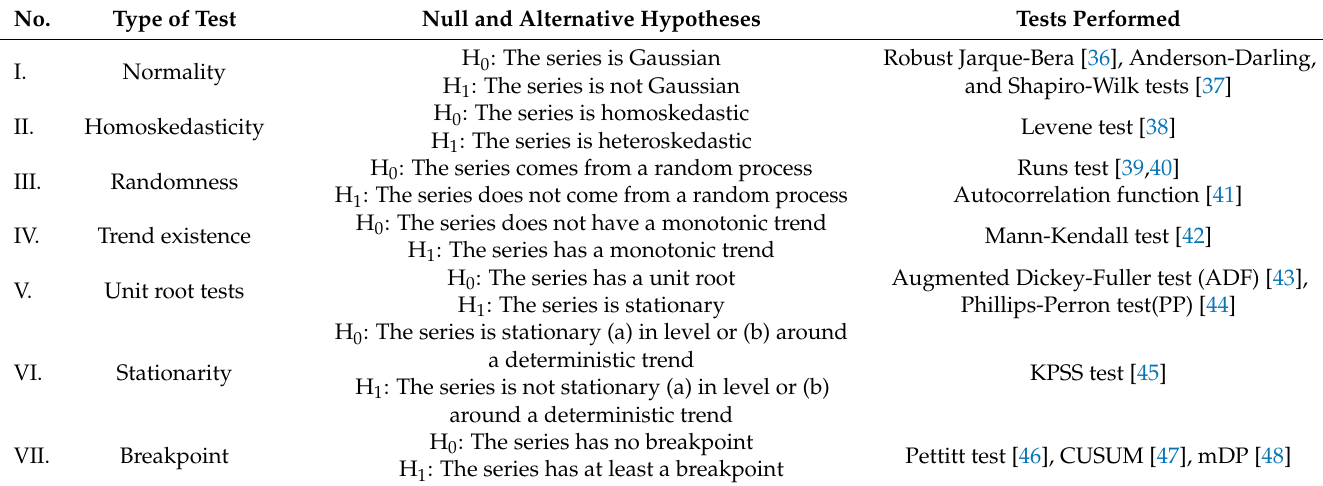
Table 1. Tests performed for data